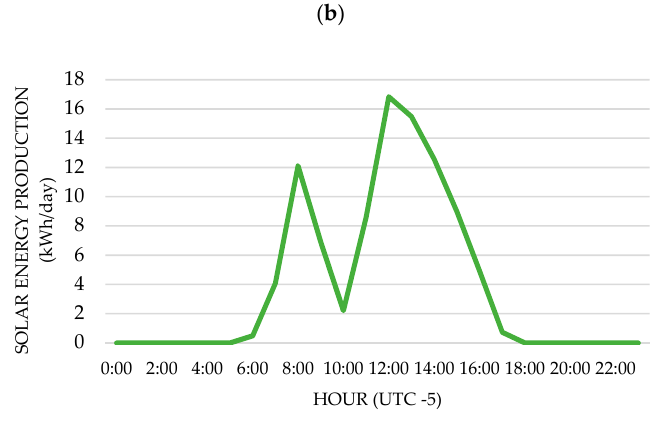
Figure 10. ( a ) Ambient temperature, ( b ) solar irradiance and ( c ) energy produced by the PV system on 22 October (time in hours corresponding to